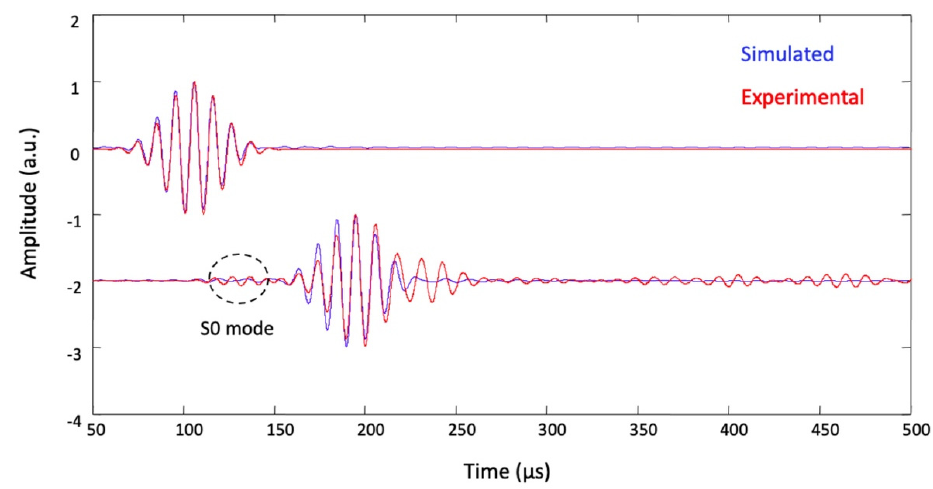
Figure 8. Comparison between reconstructed signal from the FE model and experimental measurements for two positions 142 mm apart.